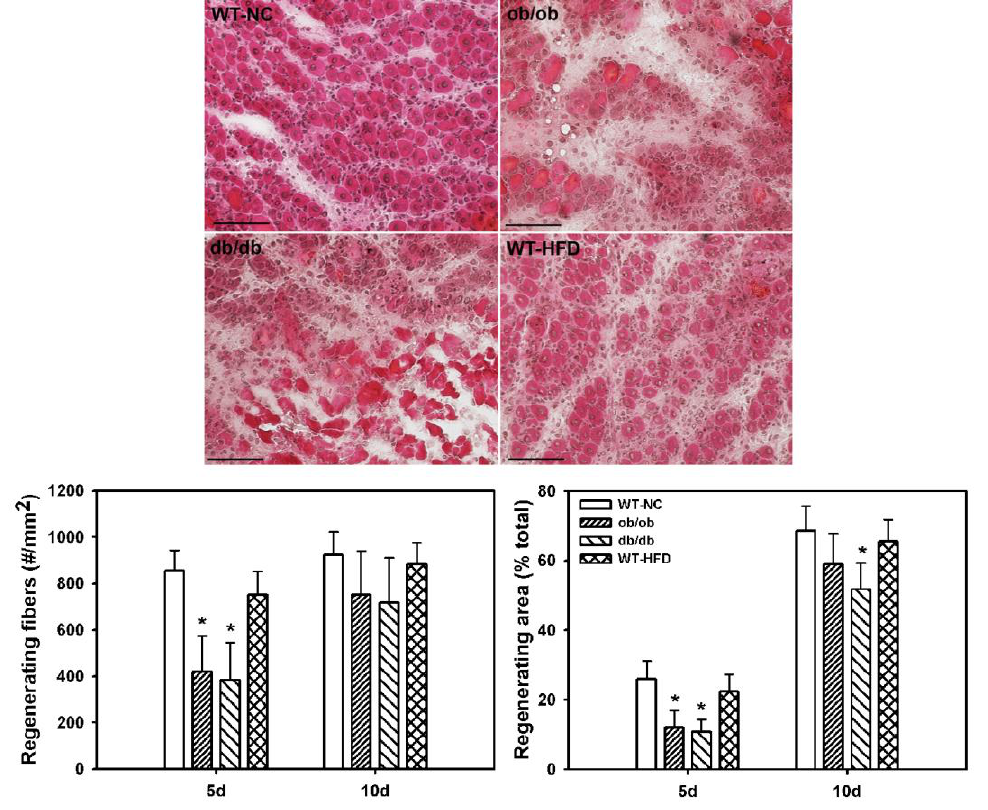
FIGURE 1. Muscle regeneration is impaired in ob/ob and db/db mice. Injured muscles collected from WT mice fed NC, ob/ob mice, db/db mice, and WT mice fed HFD. Top: cryosections of muscles collected on day 5 postinjury and stained with hematoxylin and eosin for morphological analysis. Note the relative lack of central-nucleated (regenerating) muscle fibers in ob/ob and db/db mice. Scale bar = 0.1 mm. Bottom: summary data for number of regenerating muscle fibers/mm 2 and total regenerating area as a percentage of the total muscle cross-sectional area on days 5 and 10 postinjury. Bars are means ± standard error, n = 4–6 per time point. * = Mean value significantly smaller than that for WT-NC mice; p <